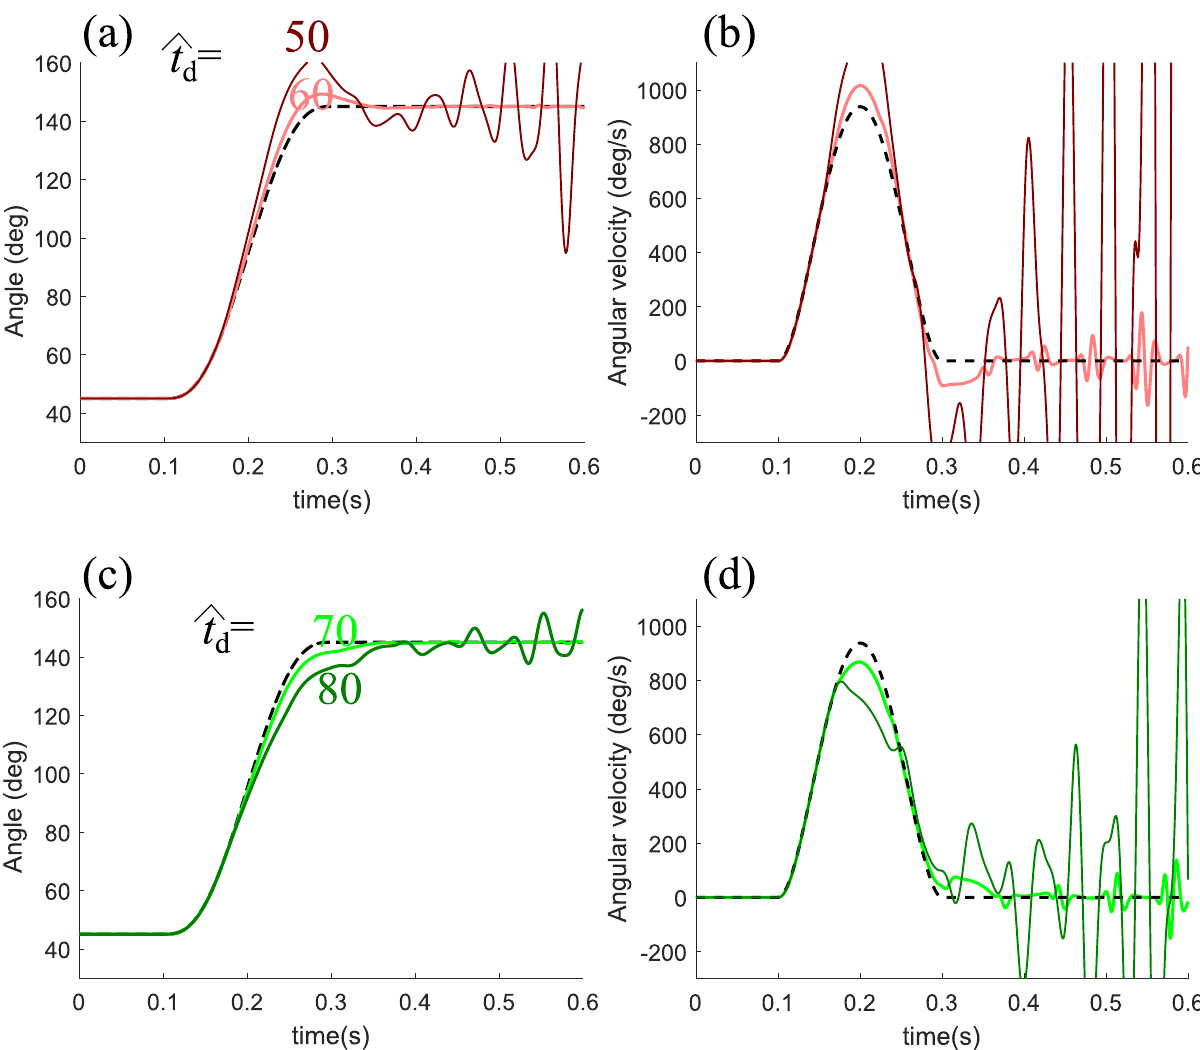
Fig 11. Sensitivity of the estimated delay ^ t at 65 ms. The top profiles of position and velocity present the cases when the value of ^ t bottom profiles of position and velocity present the cases when the value of ^ t